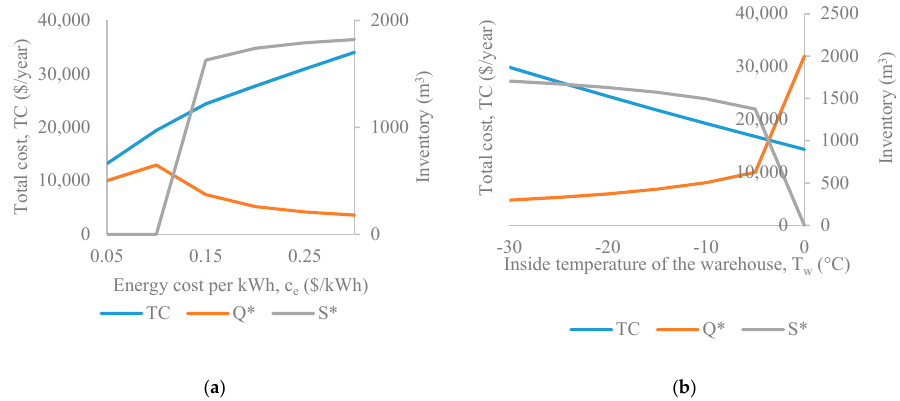
Figure 4. The behavior of the total cost and the optimum values of the decision variables, Q* and S*, for changes in the values of: ( a ) the unit energy cost, c e and ( b ) the temperature set inside the warehouse, T w .